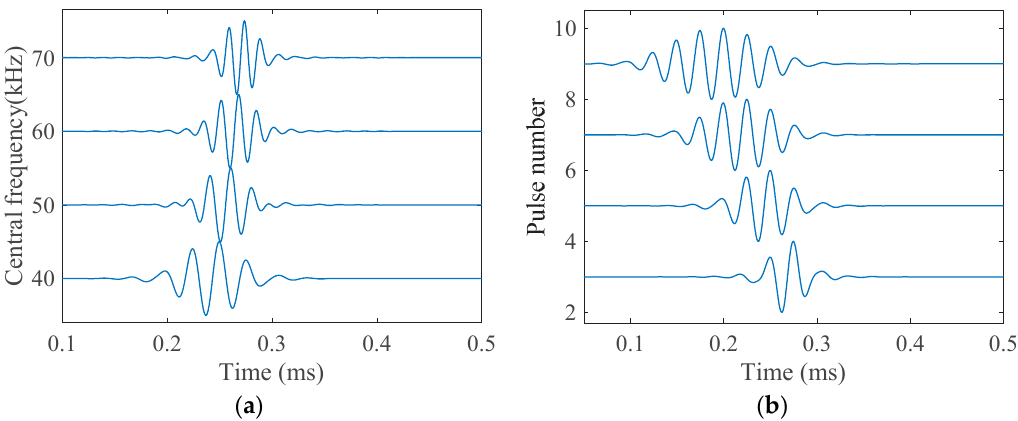
Figure 9. Reconstructed signals to ( a ) five-cycle, Hanning windowed tone bursts at various central frequencies 40 kHz, 50 kHz, 60 kHz and 70 kHz and ( b ) 40 kHz Hanning windowed tone bursts with various pulse numbers 3, 5, 7, 9 as generated by the ETRM.